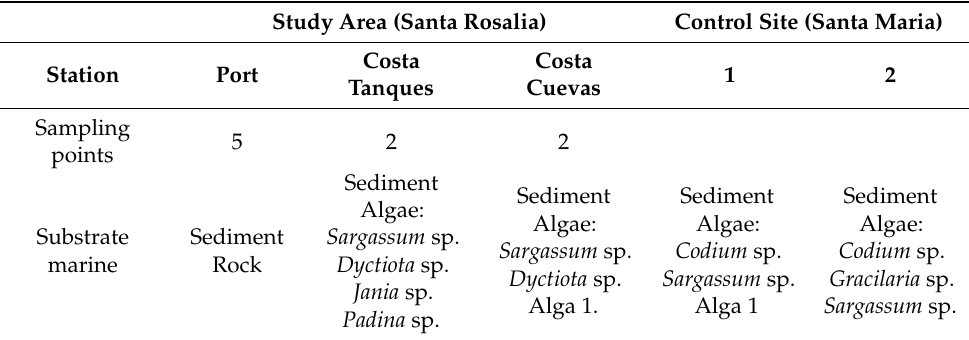
Table 1. Sampling stations and sampled substrata in the study area and control